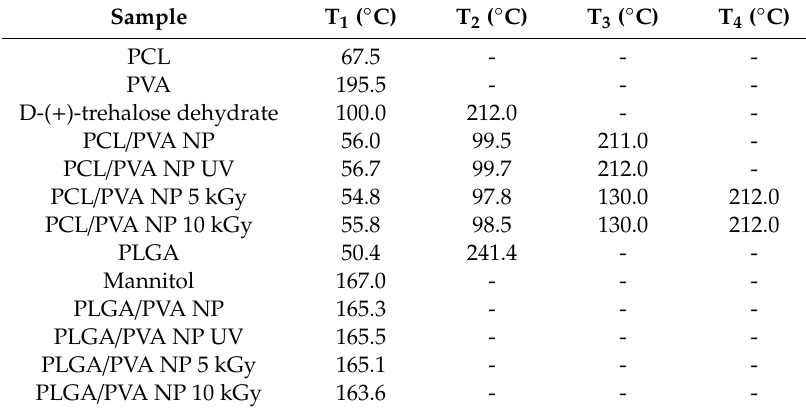
Table 2. Main thermal events of the excipients and NP before and after sterilization by UV and gamma radiation recorded by di ff erential scanning